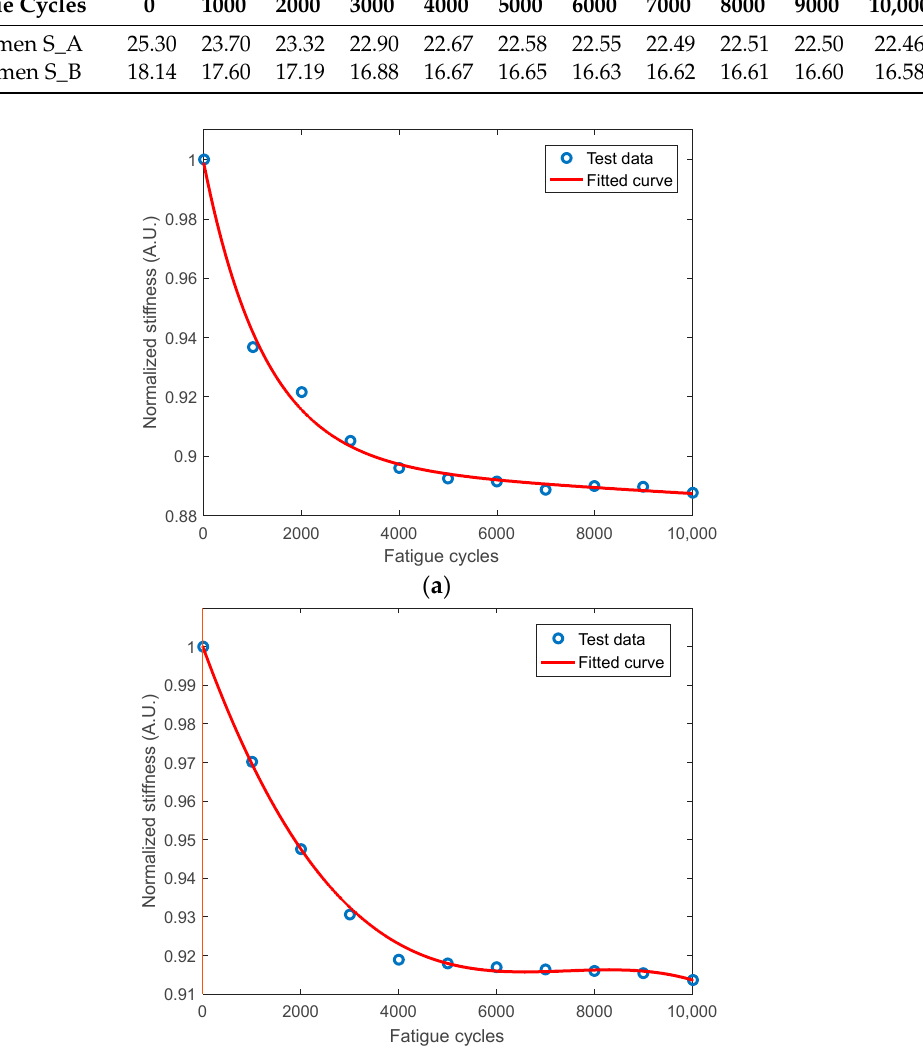
Figure 2. Longitudinal stiffness degradation with fatigue cycles: ( a ) specimen S_A and ( b ) specimen S_B.